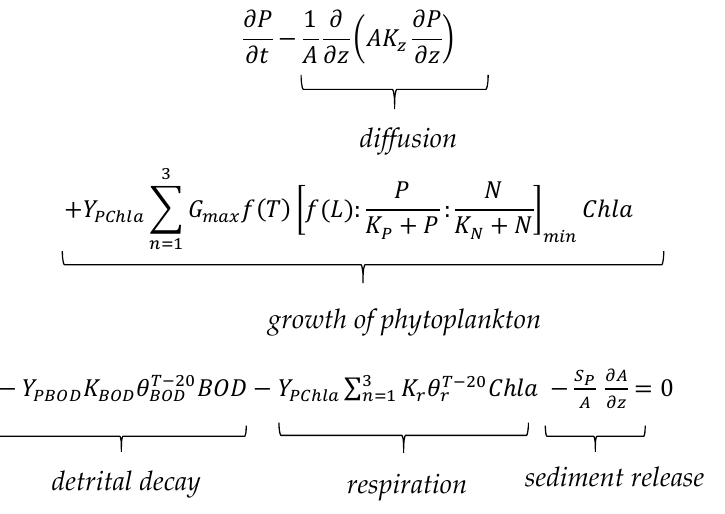
Figure 3. Schematic diagram of phosphorus cycle modeled by